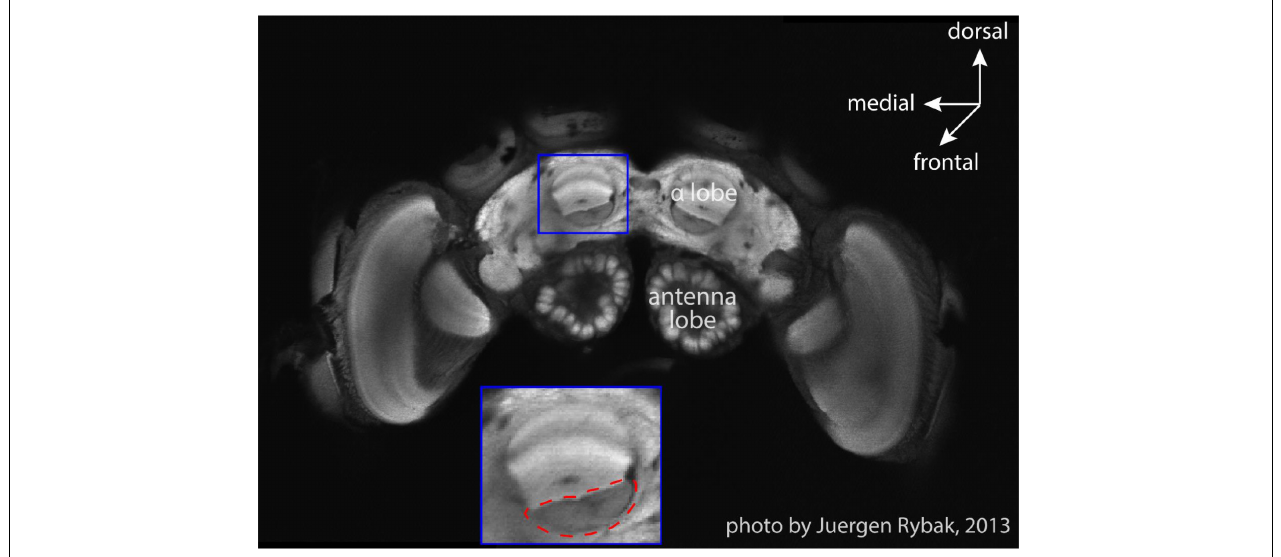
FIGURE 2 | An optical slice of bumblebee brain. The subfigure shows the zoom-in of MB vertical lobe region, and the red dashed-line circle marks the region ( β -exit of the MB vertical lobe) where copper electrodes were inserted for neural recordings (courtesy Jürgen Rybak).